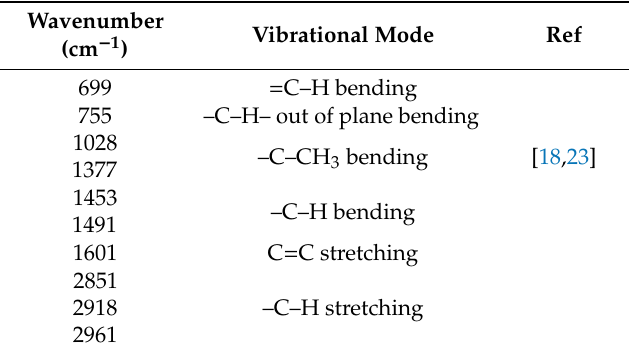
Figure 3. FTIR spectra of SEBS and its nanocomposites as a function of ( A ) the graphene (G) content up to 5 wt.% and ( B ) for the different composites with CNF, CNT, and G for filler contents of 0.25 and 5 wt.%. Table 2. Characteristic FTIR vibration bands of